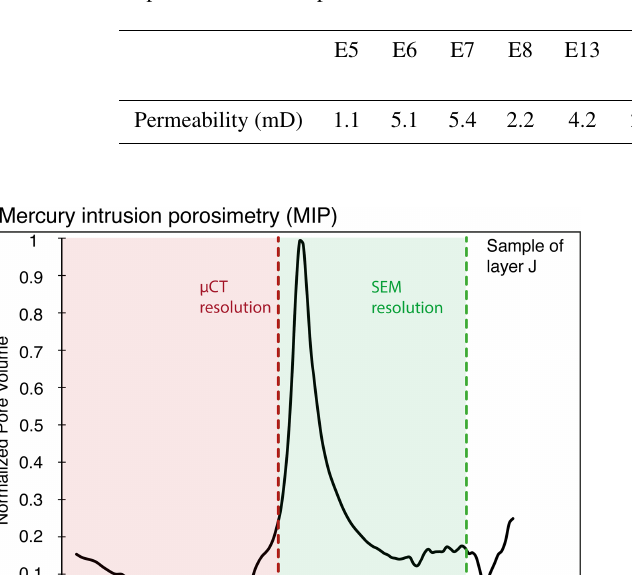
Table 2. Intrinsic permeabilities and porosities of the measured sandstone plug samples.